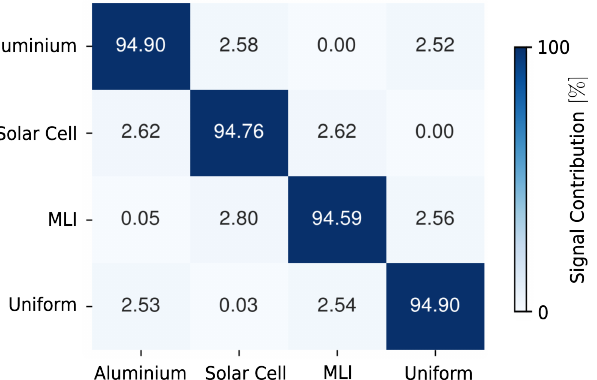
Figure 13. Confusion matrix of unmixing from observation in the bands given in Figure A1.